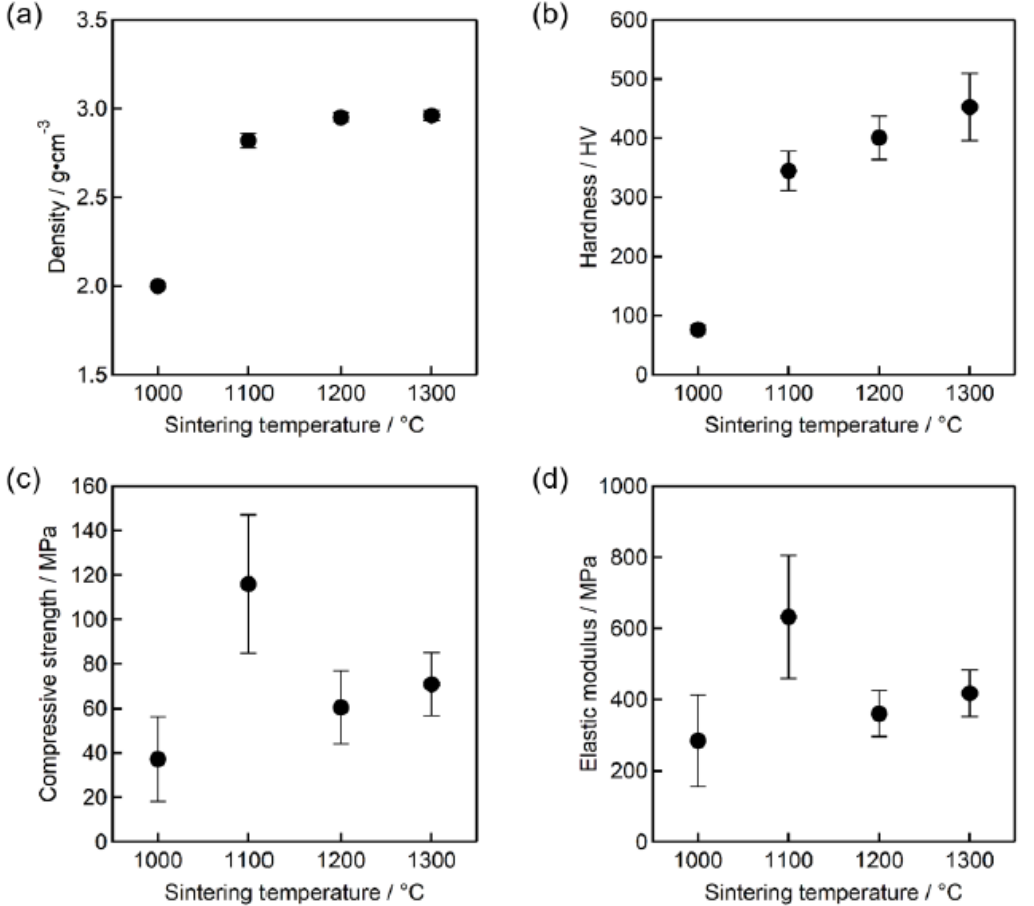
Figure 3. The effect of sintering temperature on the ( a ) density, ( b ) hardness, ( c ) compressive strength, ( d ) elastic modulus of sCaP.